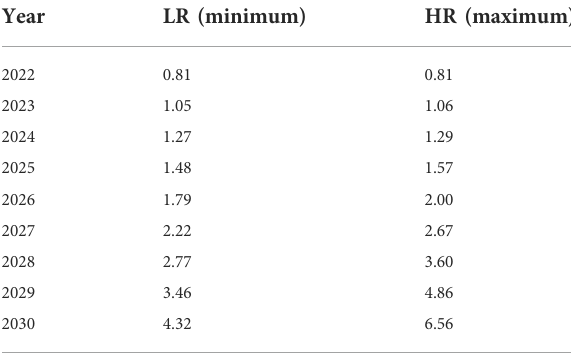
TABLE 7 Recycling potential of scrap electric passenger vehicles in China